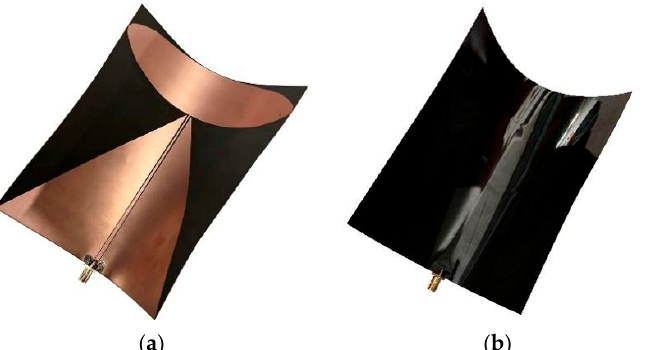
Figure 8. Physical view of the antenna: ( a ) front side of the antenna; ( b ) back side of the